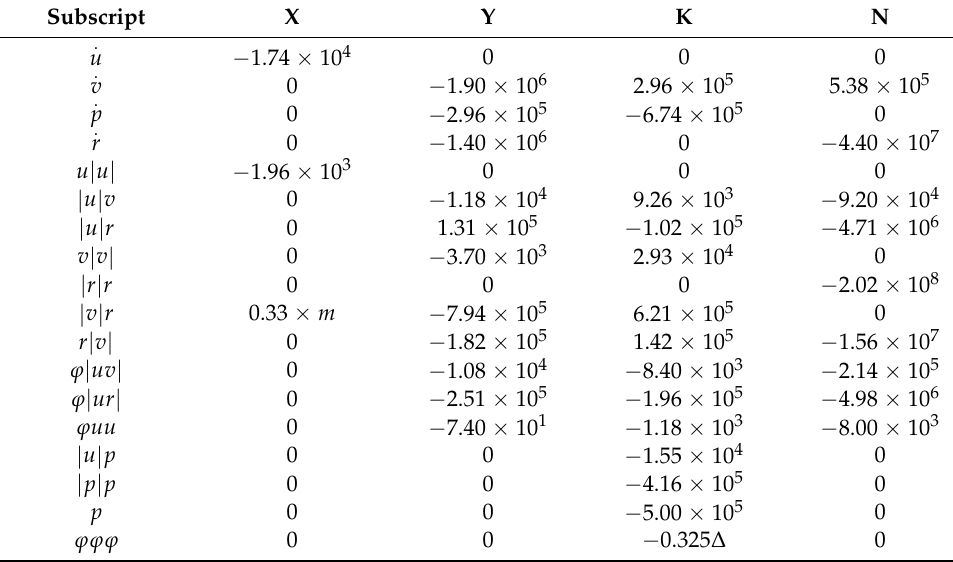
Table 3. Hydrodynamic coefficients (from